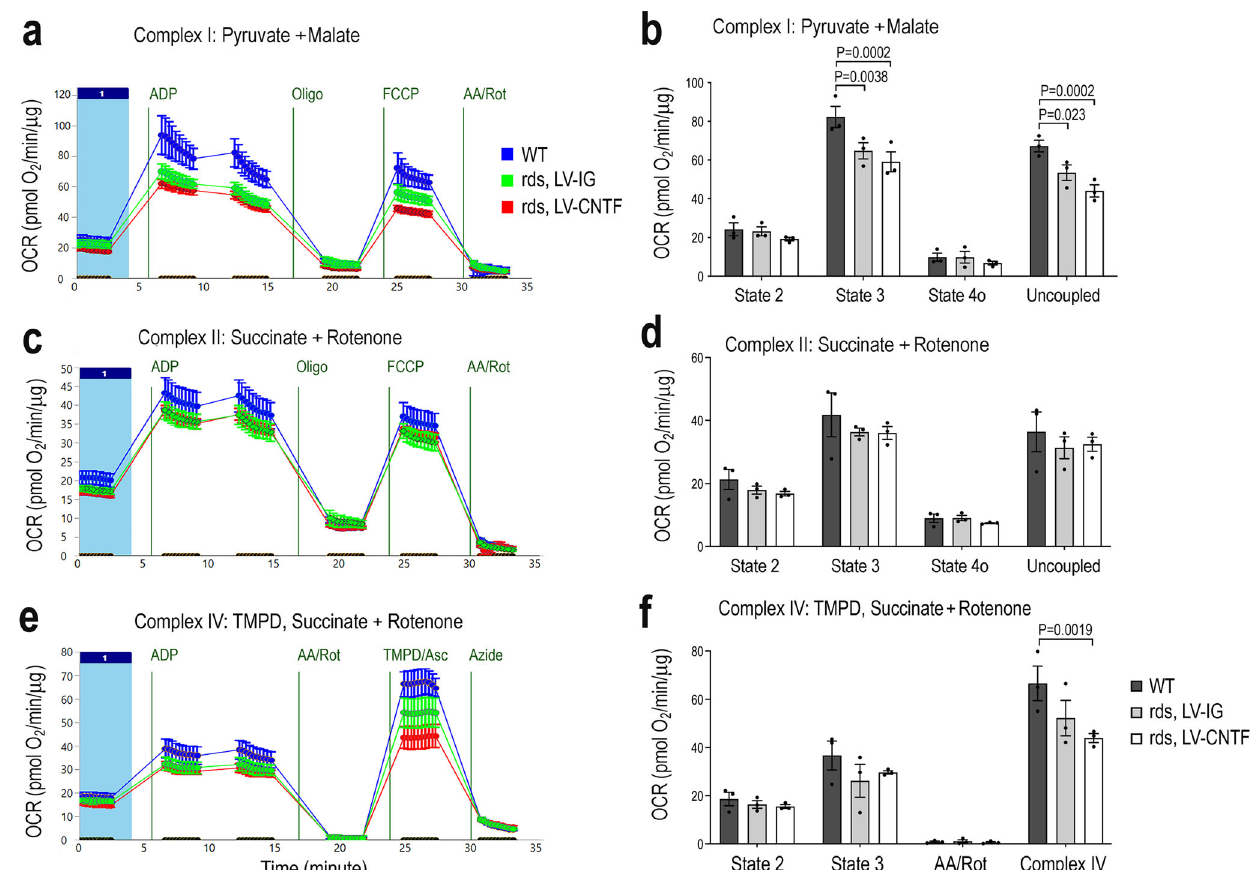
Fig. 4 | Quanti fi cation of mitochondrial respiratory chain complex